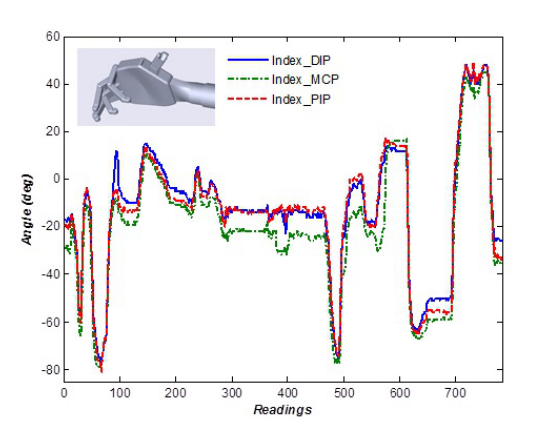
Figure 12: Index finger rotation on DIP, MCP, and PIP.